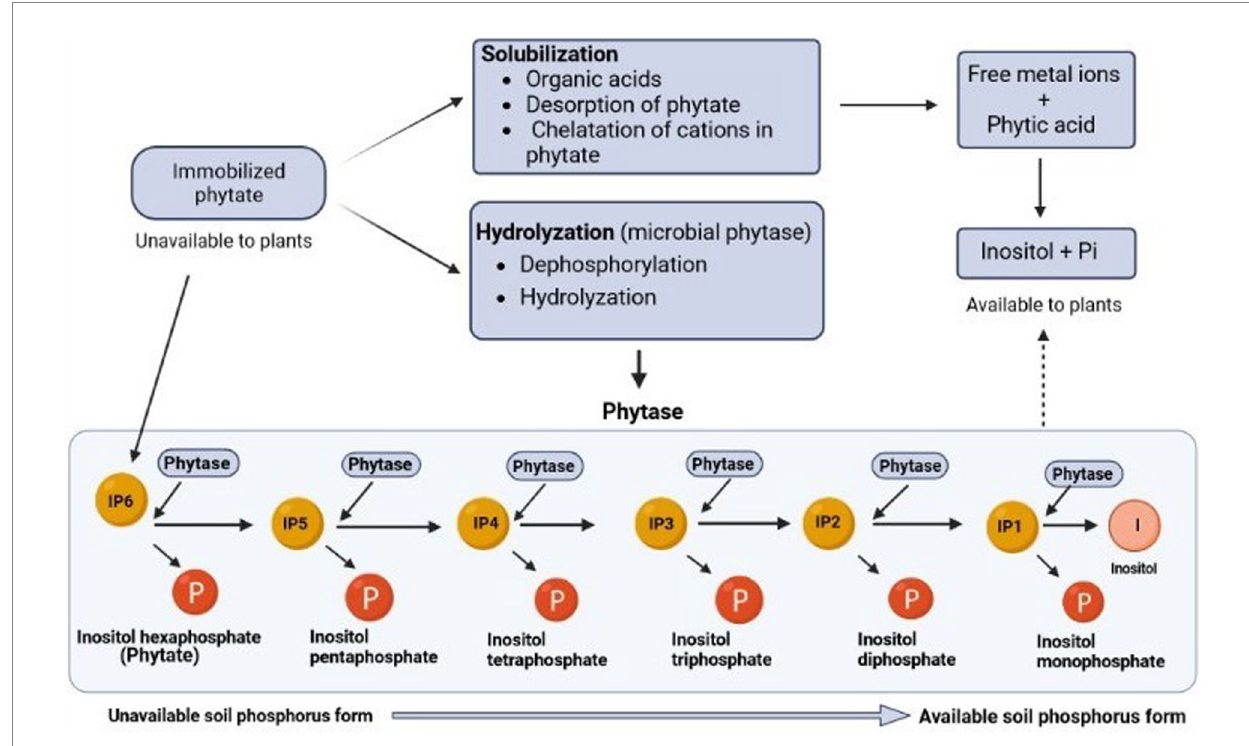
FIGURE 2 The various processes of phytate solubilization highlighting the breakdown of phytate (unavailable form) into simpler compounds (available